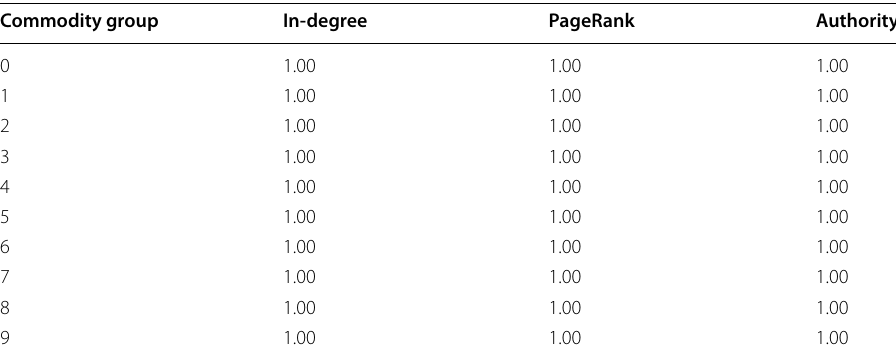
Table 6 Test of the similarity between two correlation coefficients in the two pairs of networks in case 2, in import